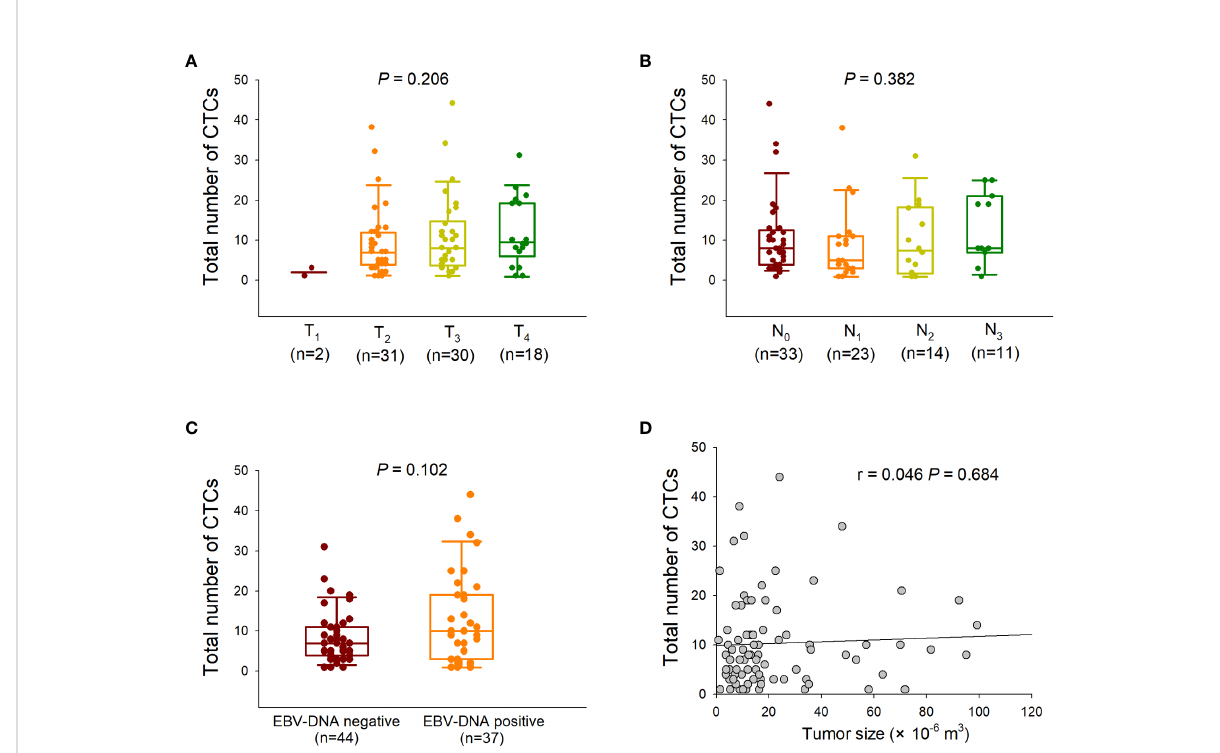
FIGURE 1 Correlation between total circulating tumor cell (CTC) numbers and clinical characteristics. (A) Comparison of the total CTC numbers among different T stages (Kruskal – Wallis one-way analysis of variance). The CTC counts are presented as vertical boxes with error bars indicating the median, 10 th , 25 th , 75 th , and 90 th percentiles. (B) Comparison of the total CTC numbers among different N stages (Kruskal – Wallis one-way analysis of variance). (C) Comparison of the total CTC numbers between Epstein – Barr virus (EBV) DNA-negative and -positive groups (Mann – Whitney U test). (D) Correlation between the total CTC numbers and tumor sizes (Pearson correlation